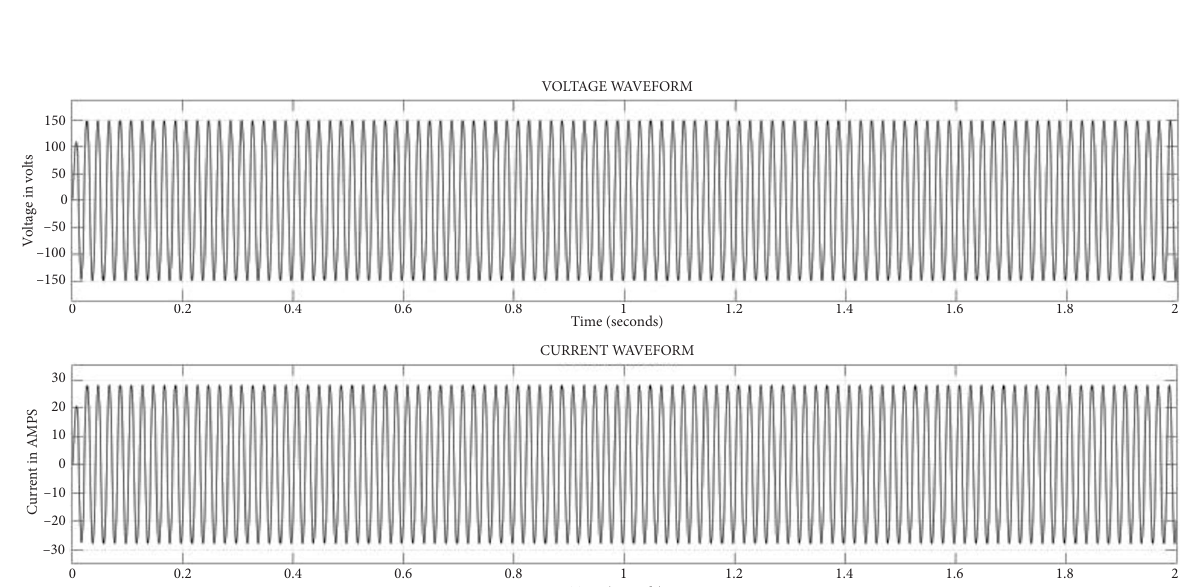
Figure 12: Output waveform during mode 2.